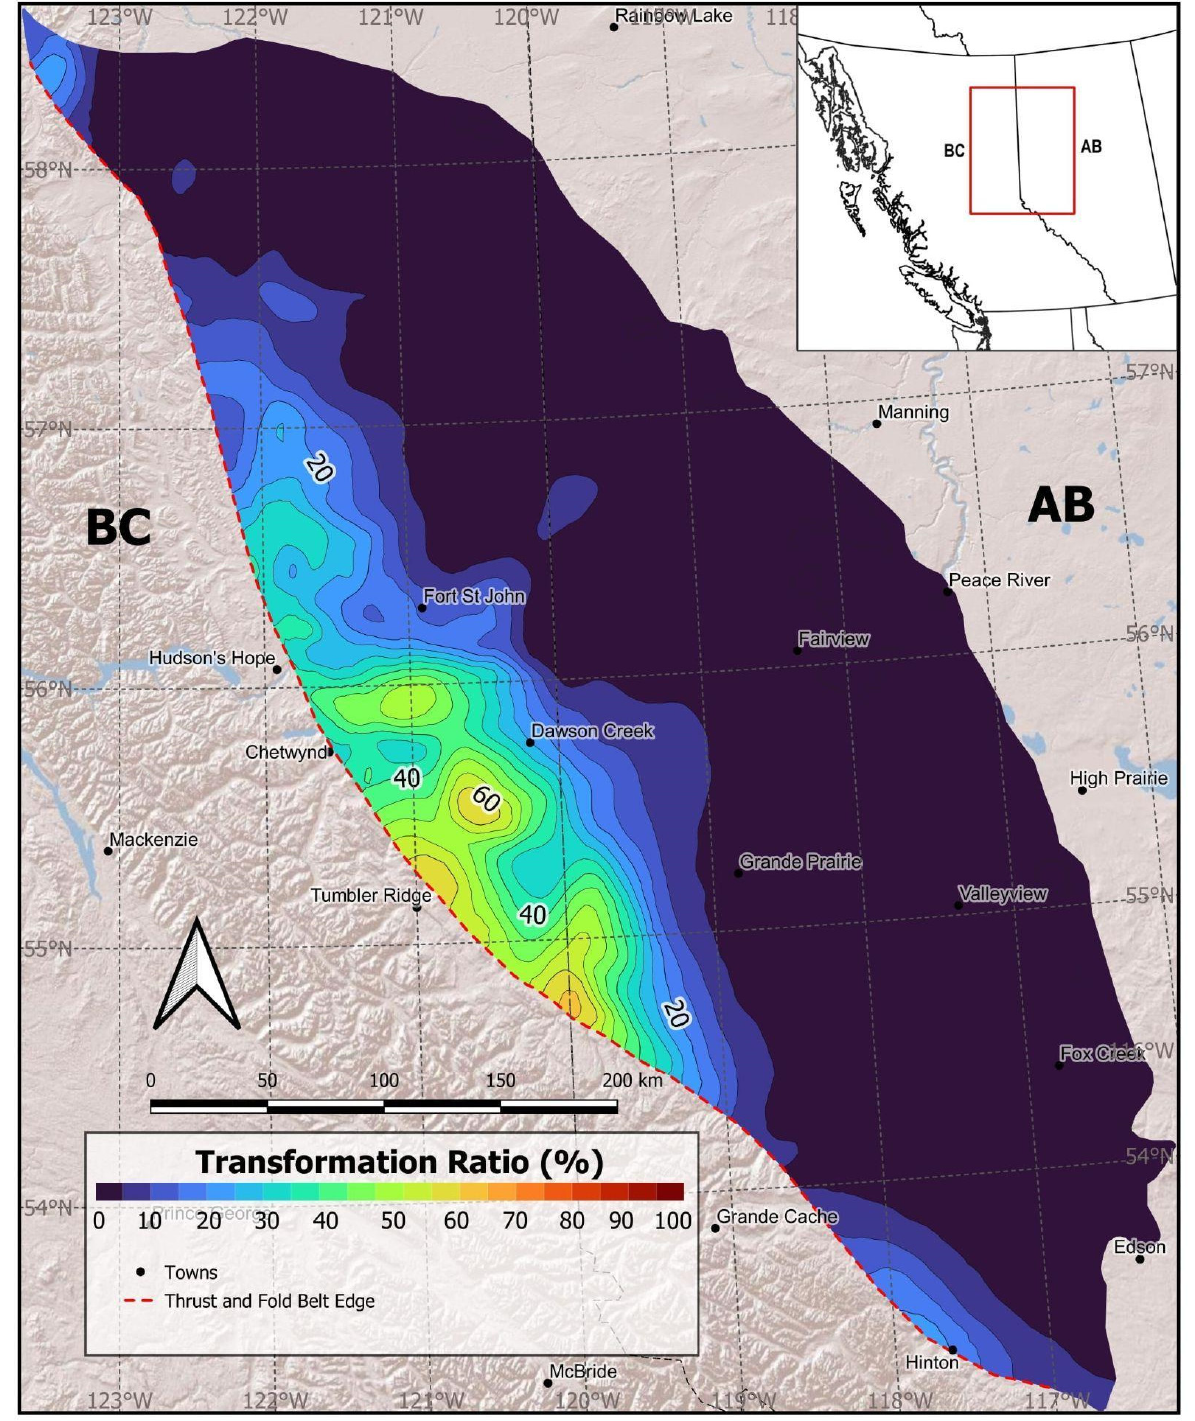
Figure 20. Kerogen transformation ratio in the Middle Montney Formation at 85 Ma. This was the time when the Montney Formation was at peak generation of hydrocarbons.